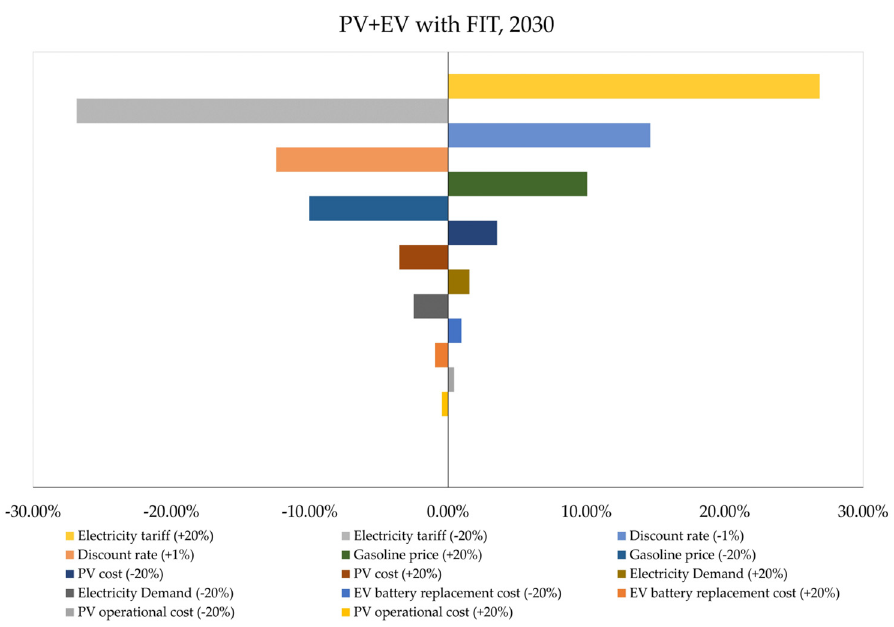
Figure 6. Sensitivity analysis for 20% increase with FITs in 2030 for various parameters.